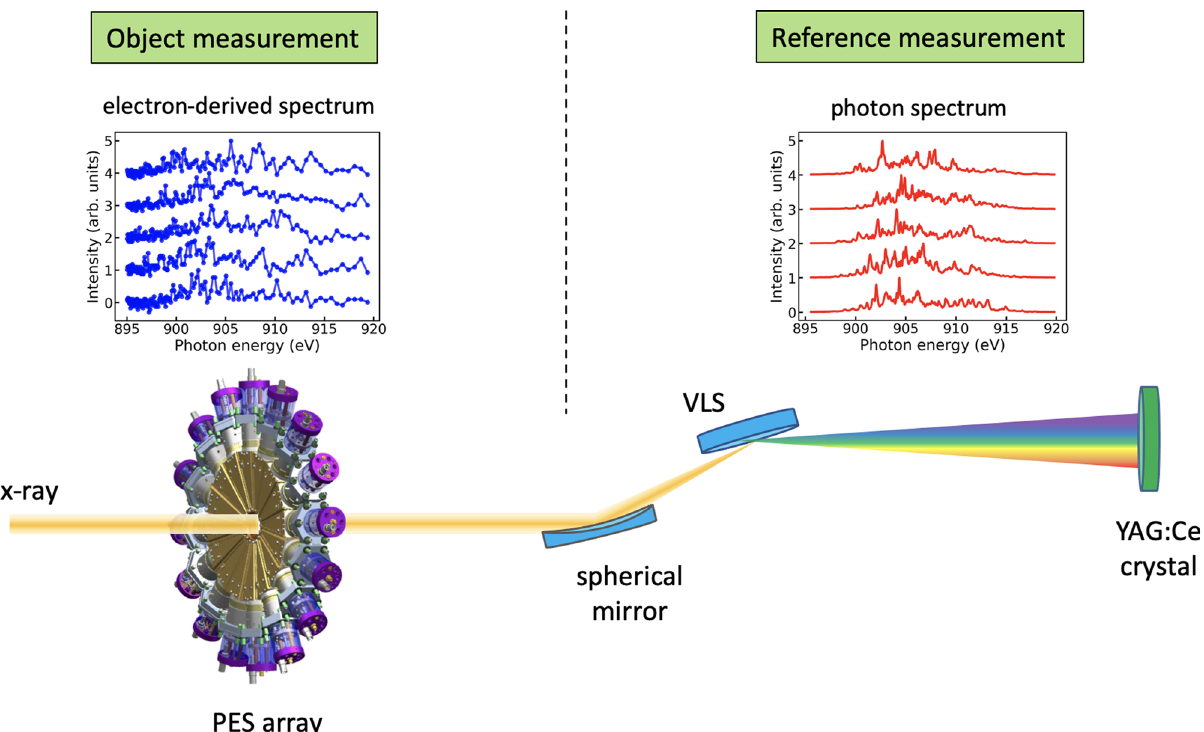
Fig. 1 Schematic of the experimental layout and elements of ghost imaging. Self-ampli fi ed spontaneous emission (SASE) x-ray free-electron laser (XFEL) pulses fi rst interact with dilute neon gas in the photoelectron spectrometer (PES) array where the kinetic energies of 1 s photoelectrons are measured by the array of electron time-of- fl ight spectrometers (eToFs). These kinetic energies are used to produce the electron-derived spectrum that forms the object measurement. The transmitted x-ray pulse is then focused on the variable-line spacing (VLS) grating by a spherical mirror and dispersed on a YAG:Ce crystal. The induced fl uorescence is recorded by a charge-coupled device (CCD) as a 2D image from which we extract the single-shot reference